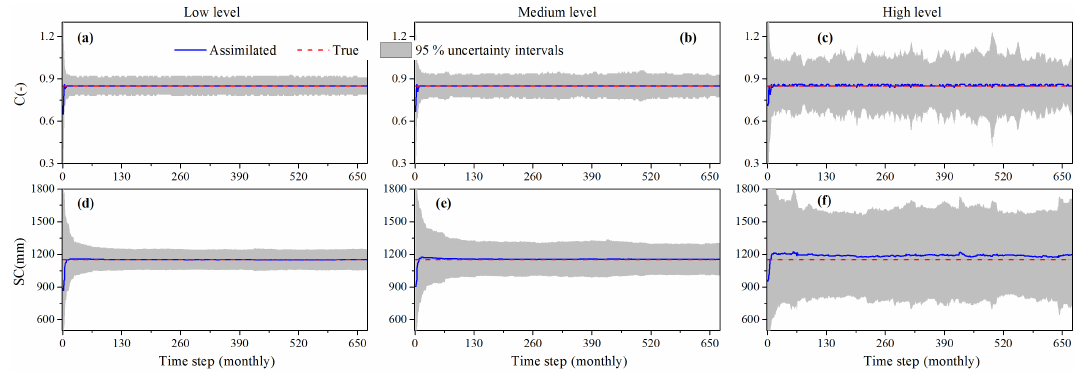
Figure 5. Estimations of time-invariant C and SC under different uncertainty levels. The gray areas represent the 95% prediction uncertainty intervals. Table 4. Performance statistics for various changes of (a) parameter C and (b) SC estimations under different levels of uncertainty in the synthetic